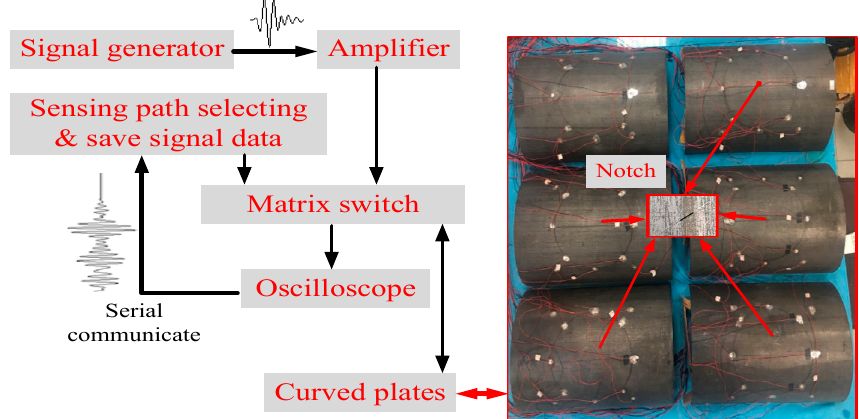
Figure 4. Hardware and software developed to real-time monitoring the curved plates.